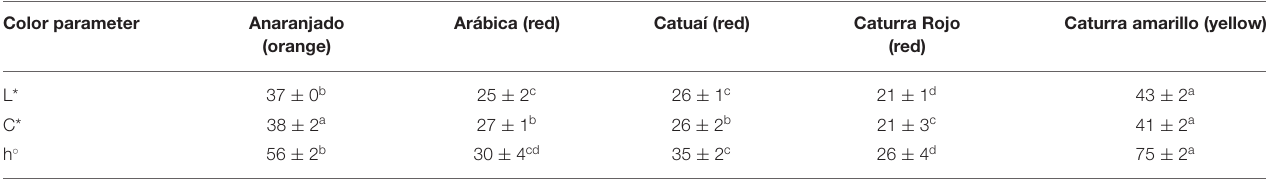
TABLE 6 | Color parameters of peels from different coffee genotypes. Color parameter